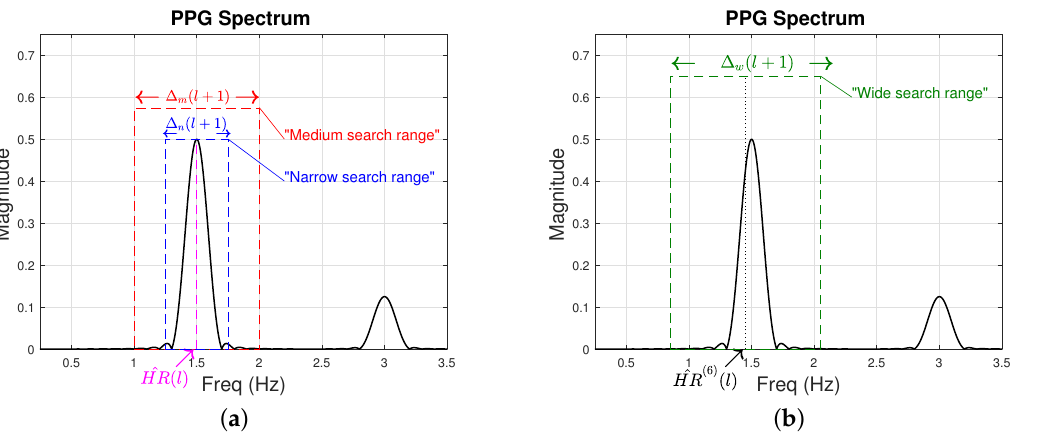
Figure 4. Illustration of the frequency spectrum of typical IR PPG signal. ( a ) The narrow search range, ∆ ∆ n ( l + 1 ) and the medium search range, m ( l + 1 ) are illustrated as a blue and a red dashed rectangle, respectively. Both ranges are centered around ˆ HR ( l ) = 1.5 Hz which is shown as a magenta dashed line. These ranges are used for noise frequency component search. ( b ) The wide search range, ∆ ˆ HR ( 6 ) ( l ) w ( l + 1 ) is illustrated as a green dashed rectangle. The wide search range is centered at (black dotted line) and is used to search, at time step l + 1, for ˆ HR ( l + 1 )